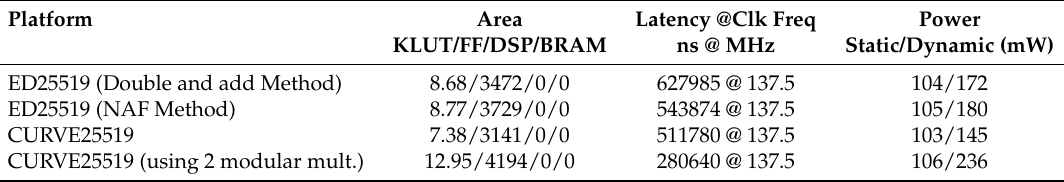
Table 2. Implementation results of ED25519 and CURVE25519 point multiplication cores on ZYNQ 7000 Series.